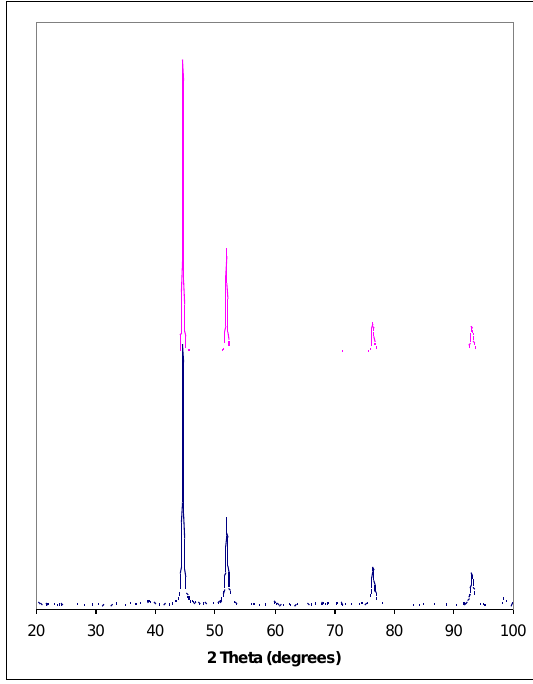
Figure 6. XRD spectra of pure Ni (upper) and an 8-hour wet treated sample (lower)